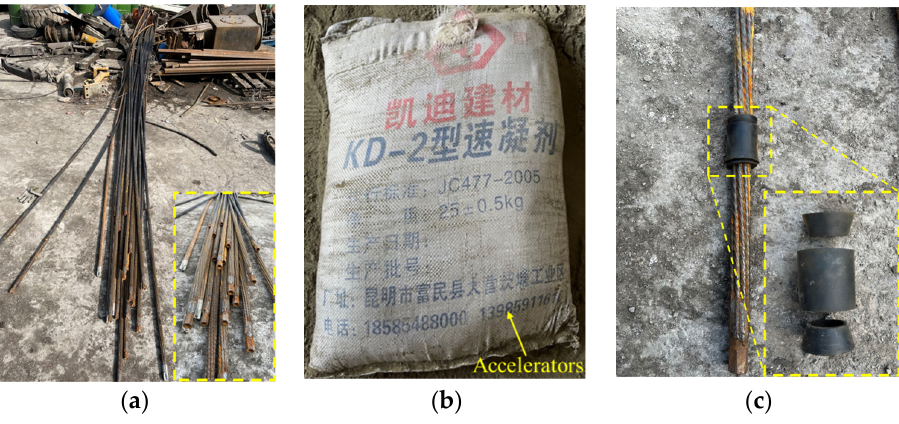
Figure 10. Materials used for CUSG support. ( a ) Hollow grouted anchor cable, ( b ) KD-2 accelerators, and ( c ) slurry blocking rubber sleeve.